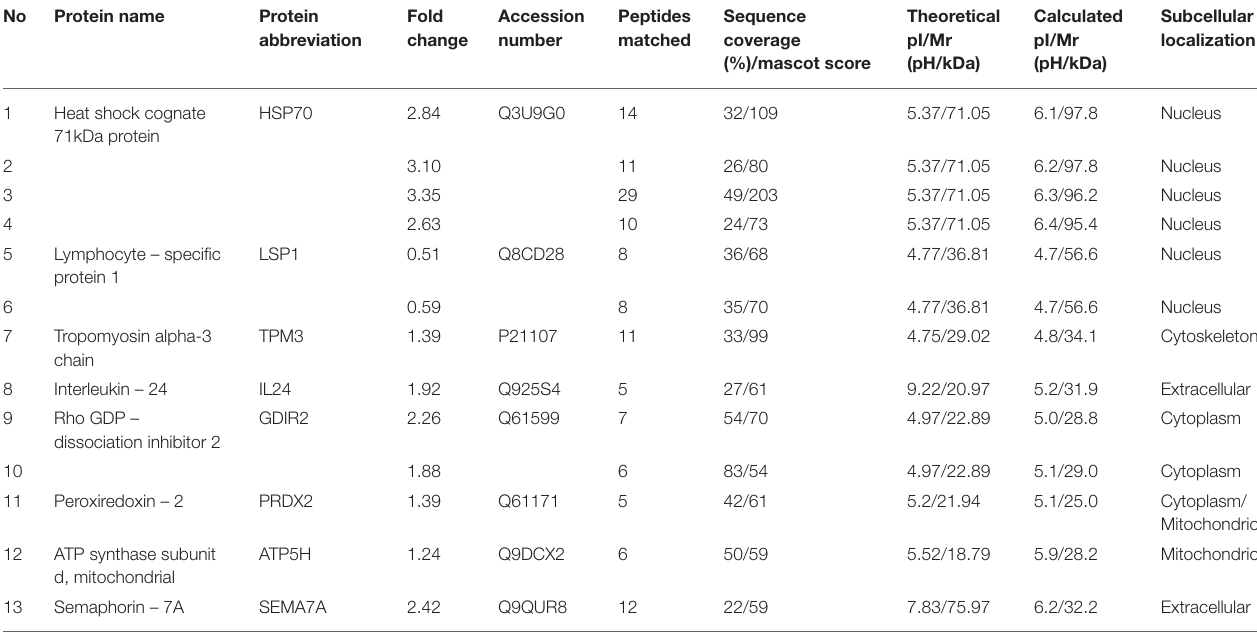
TABLE 4 | The list of differentially expressed proteins of splenic CD4 + T cells between mice after the transfer of TNF α -treated embryos in comparison to mice after the transfer of biologically competent embryos (Student’s t- test p ≤ 0.05).